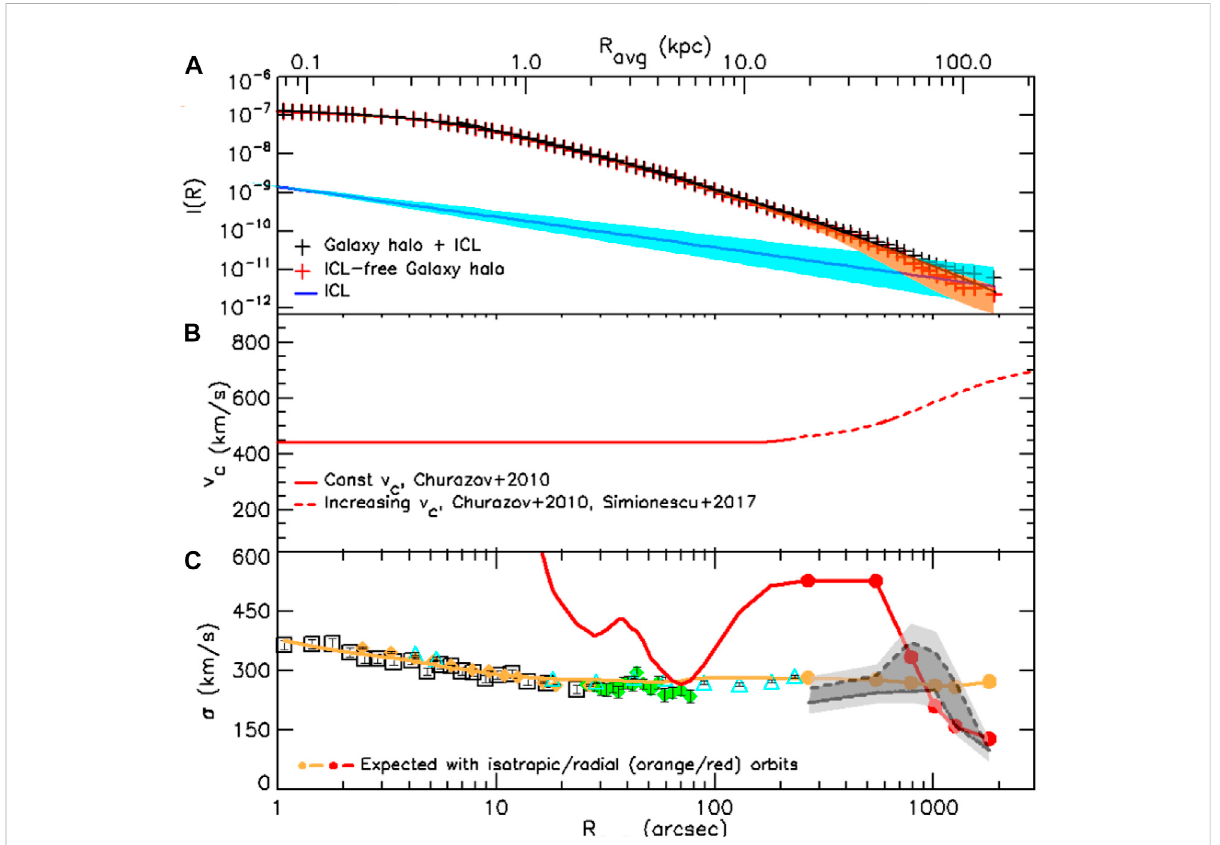
FIGURE 7 Dynamics of the smooth M87 halo out to 2000 ″ compared with predictions from Jeans equations. Panel (A) surface brightness pro fi le of the M 87smoothhalo(redcrossesandshadedarea)obtainedfrom theextendedphotometry(Kormendyetal., 2009), after subtractingtheICLcontribution(blue line and shaded area). The black continuous line shows the Sersic fi t with n = 11 to the total halo + ICL extended photometry. The adopted circular velocity pro fi le based on X-ray data is shown in panel (B) . Panel (C) velocity dispersion pro fi le σ ( R ) from IFS (squares, triangles) and long slit (diamonds) data (source:Longobardietal.,2018a).Largedotsrepresenttheexpected σ valuesattheaverageradiioftheradialbins,forisotropic(orange)andcompletelyradial (red) orbital anisotropy. The comparison with the range of σ values for halo PNe (shaded area) suggests that the distribution of orbits changes from near- isotropic at ~200 ″ to strongly radial at ~2000 ″ . Image reproduced from Longobardi et al. (2018a) with